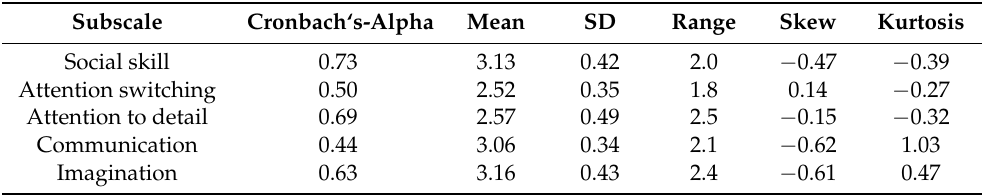
Table 6. Properties of subscales of the